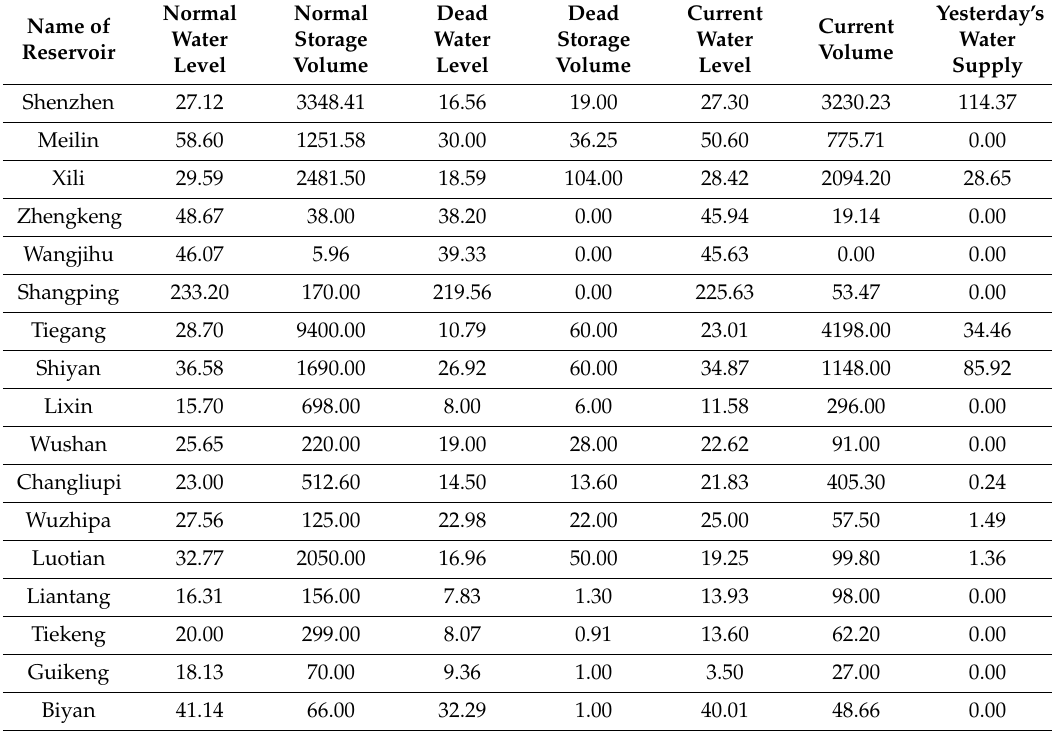
Table A1. Initial state of reservoirs in the whole city on 2 March